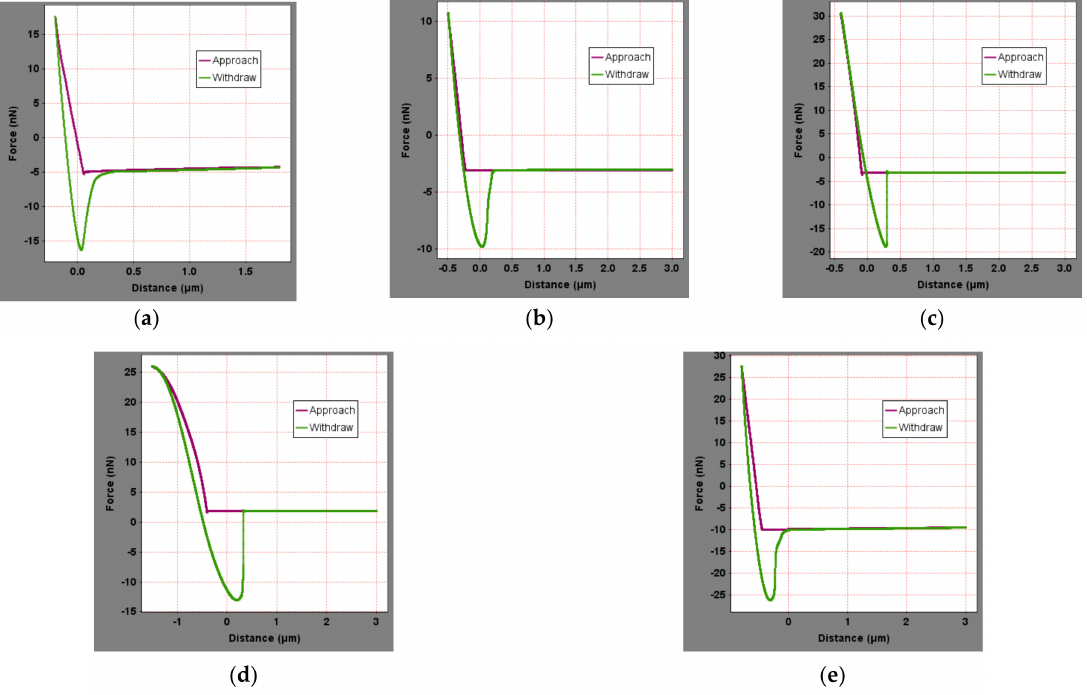
Figure 6. Force curves of original asphalt binder: ( a ) SK-70, ( b ) KL-70, ( c ) Shell-70, ( d ) SK-90, and ( e )